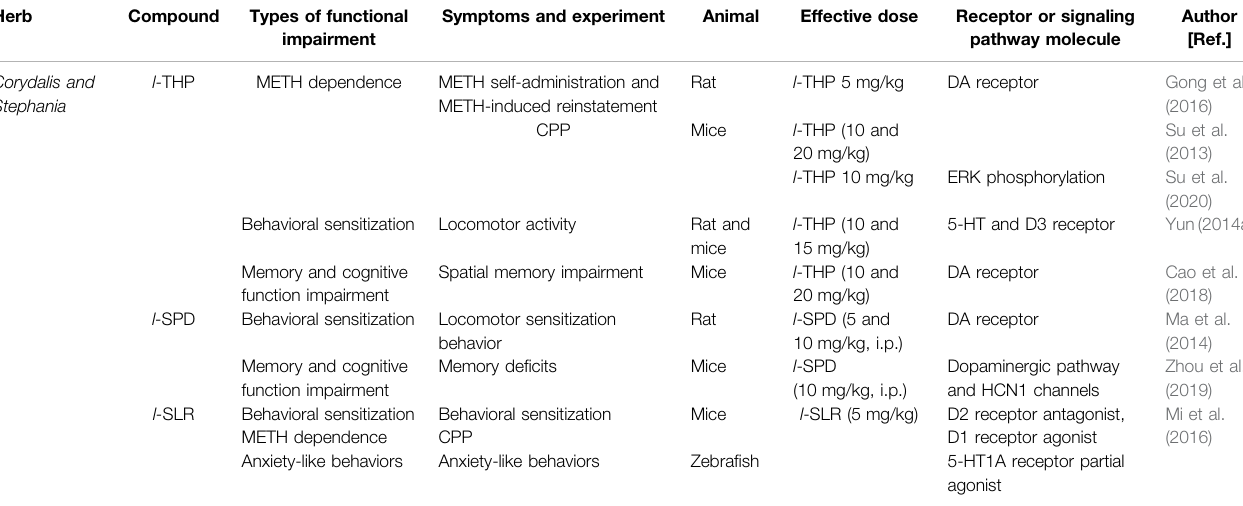
TABLE 2 | Summarized effects of TCM Corydalis and Stephania therapy on METH abuse and other psychiatric symptoms. Herb